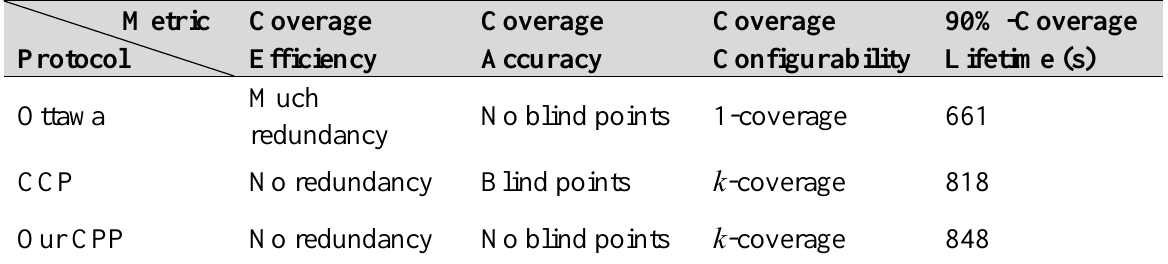
Table 2. Comparison among